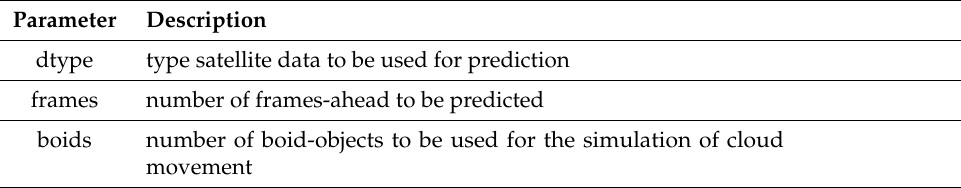
Table 1. Parameters for a Prediction